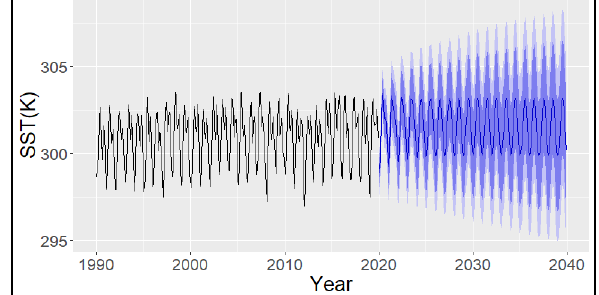
Figure 6 . SST forecast using ARIMA for the period 2020 to